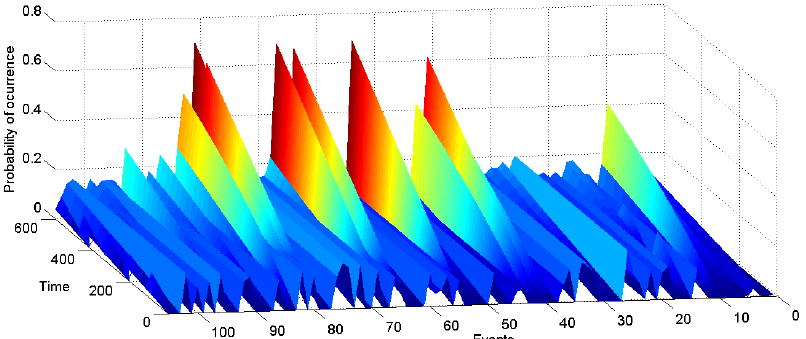
Figure 4. Occurrence probabilities of events.